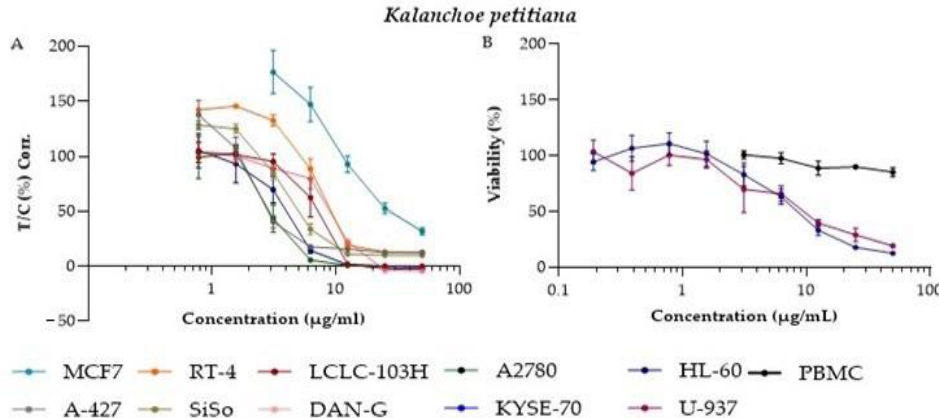
Figure 1. Antiproliferative and inhibitory effect on the viability of 4 extracts against 10 cancer cell lines and PBMCs: ( A ) concentration-response curve of A. schimperi , E. schimperiana , K. foliosa, and K. petitiana induced antiproliferative activity in MCF-7, A427, RT-4, SiSo, LCLC-103H, DAN-G, A2780, and KYSE-70 cell lines; ( B ) concentration–response curve of A. schimperi , E. schimperiana , K. foliosa , and K. petitiana induced inhibition of cell viability in HL-60 and U-937 cell lines as well as PBMC. Attachment and suspension cells were incubated with increasing concentrations of the extracts in culture medium for 96 h (crystal violet assay) and 24 h (MTT assay), respectively. Data are expressed as means ± SEM. Table 2. IC 50 values (µg/mL) for the activities of crude extracts against 10 human cancer MCF-7,